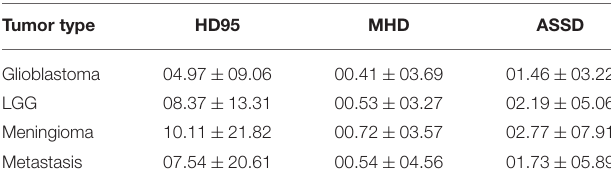
TABLE 7 | Voxel-wise performance summary for each tumor type for spatial distance-based